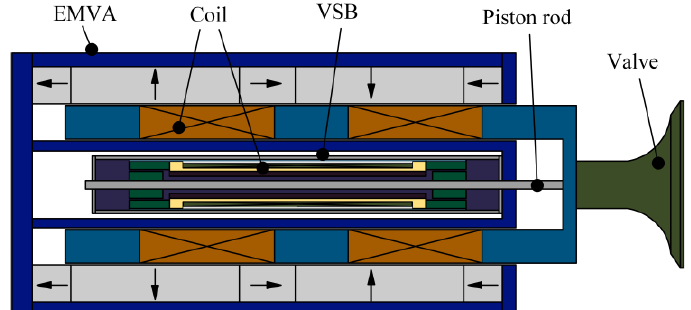
Figure 2. New structure of EMVV system.